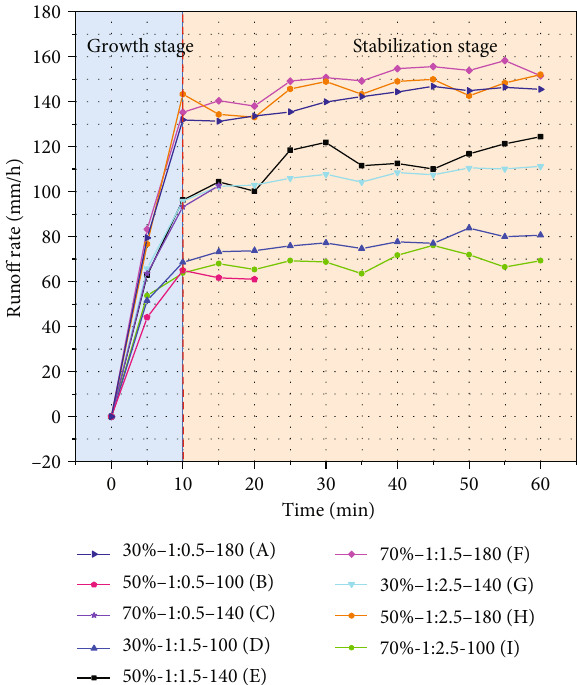
Figure 8: Runo ff rate of the clay gravel slope.